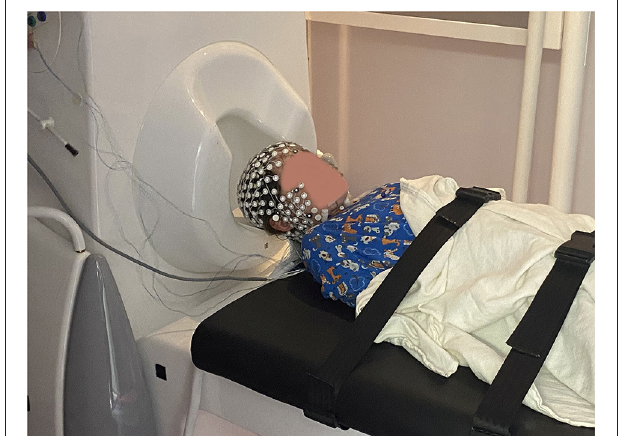
FIGURE 1 | Setup of the MEG/HD-EEG recordings at CCMC. The patient lays down on a MEG-compatible bed, then the bed is pushed in to place her head inside the helmet. The HD-EEG recordings are performed simultaneously using a net that accommodates a high number of electrodes (i.e., 256). These electrodes do not require the application of gel in order to achieve high conductivity between the patient’s scalp and the electrode, accelerating the patient’s preparation